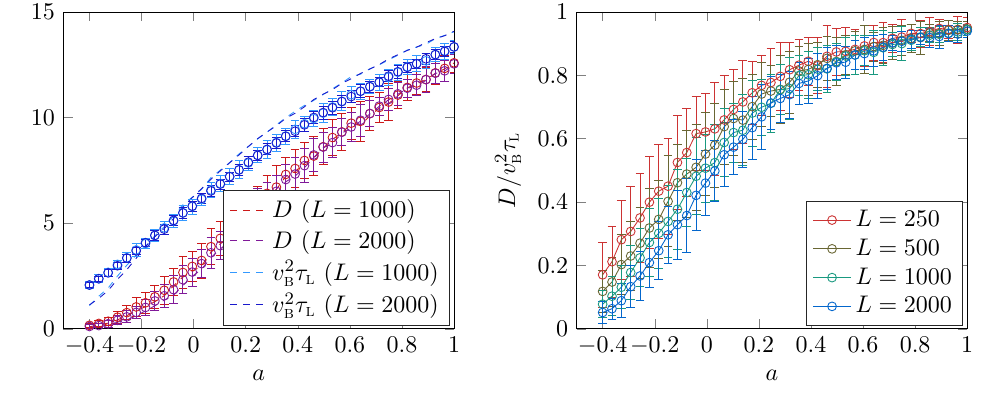
τ F IGURE 1: Left: the value of D and v 2 , predicted theoretically (from (20) and L B = ( 1 + (cid:74) 2 ) − 1 , with (26)) and found numerically, in an inhomogeneous chain with J 2 1 (cid:74) = a + a = 0.5 and a = 0.6. The trend of v 2 τ cos ( 2 π x / M ) for a to decrease at smaller 0 1 0 1 L B M towards the “limit" set by diffusion is evident. Right: disordered profiles with (cid:74) = a (cid:80) + k c x ) and c with X = cos ( φ and φ random variables chosen so that X ∼ O ( 1 ) . We n n n n n = 0.5 and vary a τ take a , and study the ratio D / v 2 as a function of M for different re- 0 1 L B alizations of disorder. Discrepancies between the two are enhanced as M becomes large, as expected. We have set L = 6000 and β J = 25.